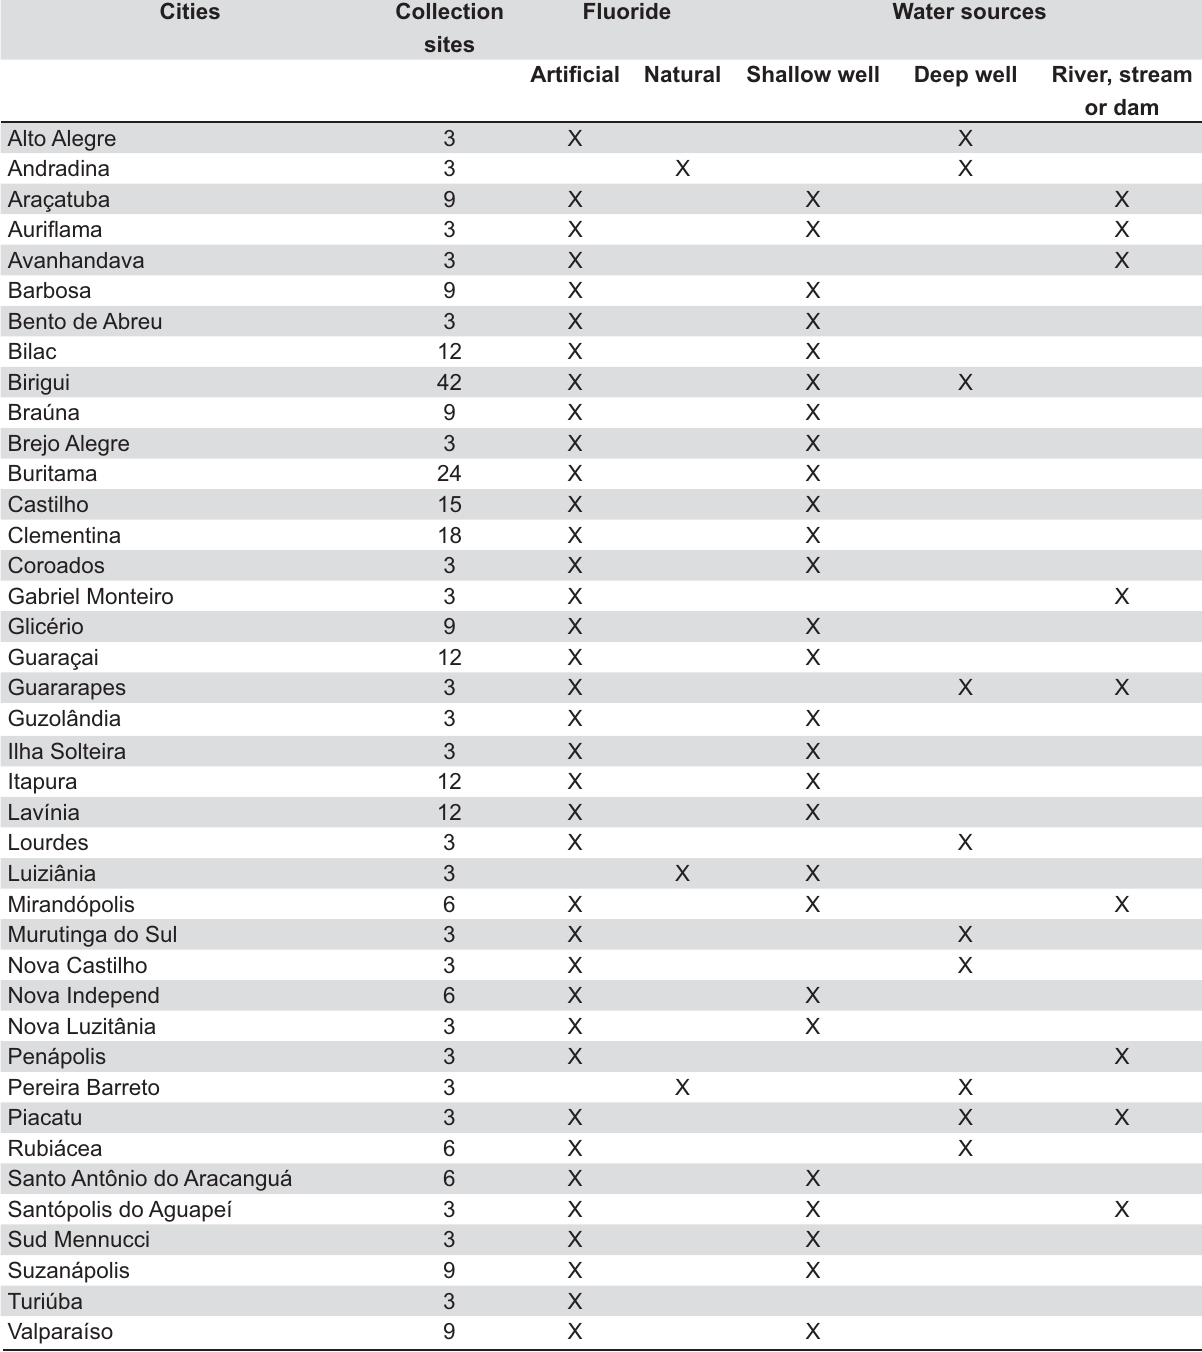
Table 2- (cid:9)(cid:29)(cid:3)(cid:8)(cid:13)(cid:19)(cid:4)(cid:9)(cid:14)(cid:16)(cid:9)(cid:20)(cid:14)(cid:18)(cid:18)(cid:19)(cid:20)(cid:12)(cid:5)(cid:14)(cid:15)(cid:9)(cid:11)(cid:5)(cid:12)(cid:19)(cid:11)(cid:26)(cid:9)(cid:3)(cid:12)(cid:5)(cid:18)(cid:5)(cid:25)(cid:7)(cid:12)(cid:5)(cid:14)(cid:15)(cid:9)(cid:14)(cid:16)(cid:9)(cid:15)(cid:7)(cid:12)(cid:3)(cid:4)(cid:7)(cid:18)(cid:9)(cid:14)(cid:4)(cid:9)(cid:7)(cid:4)(cid:12)(cid:5)(cid:30)(cid:20)(cid:5)(cid:7)(cid:18)(cid:18)(cid:31)(cid:9)(cid:7)(cid:27)(cid:27)(cid:19)(cid:27)(cid:9)(cid:6)(cid:3)(cid:14)(cid:4)(cid:5)(cid:27)(cid:19)(cid:9)(cid:5)(cid:15)(cid:9)(cid:12)!(cid:19)(cid:9)(cid:17)(cid:3)(cid:13)(cid:18)(cid:5)(cid:20)(cid:9)(cid:21)(cid:7)(cid:12)(cid:19)(cid:4)(cid:9)(cid:11)(cid:3)(cid:17)(cid:17)(cid:18)(cid:31)(cid:26)(cid:9)(cid:7)(cid:15)(cid:27)(cid:9)(cid:12)!(cid:19)(cid:9)(cid:12)(cid:31)(cid:17)(cid:19)(cid:9) of water supply source for the 40 Brazilian cities in this study from November 2004 to October 2011